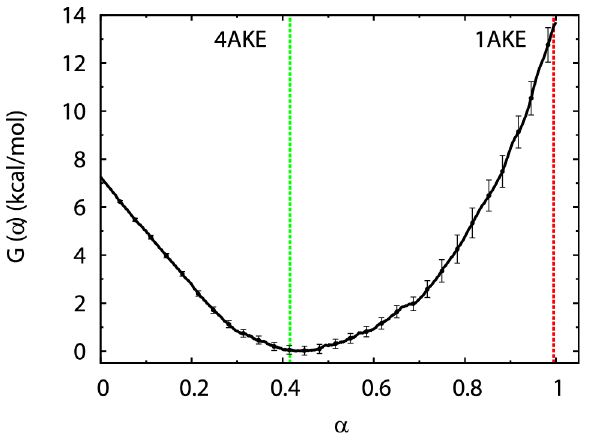
Figure 6. Free energy profile of AdK conformations. The free energy G a ð Þ was defined along a conformational pathway (see Methods), and calculated from the umbrella-sampling simulations. The plotted error bars are for the free energy difference with respect to the first umbrella window at a =0, estimated from the statistical uncertainties in the mean coordinate [40]. The green and red dashed lines indicate the projected locations of the open and closed crystal structures,